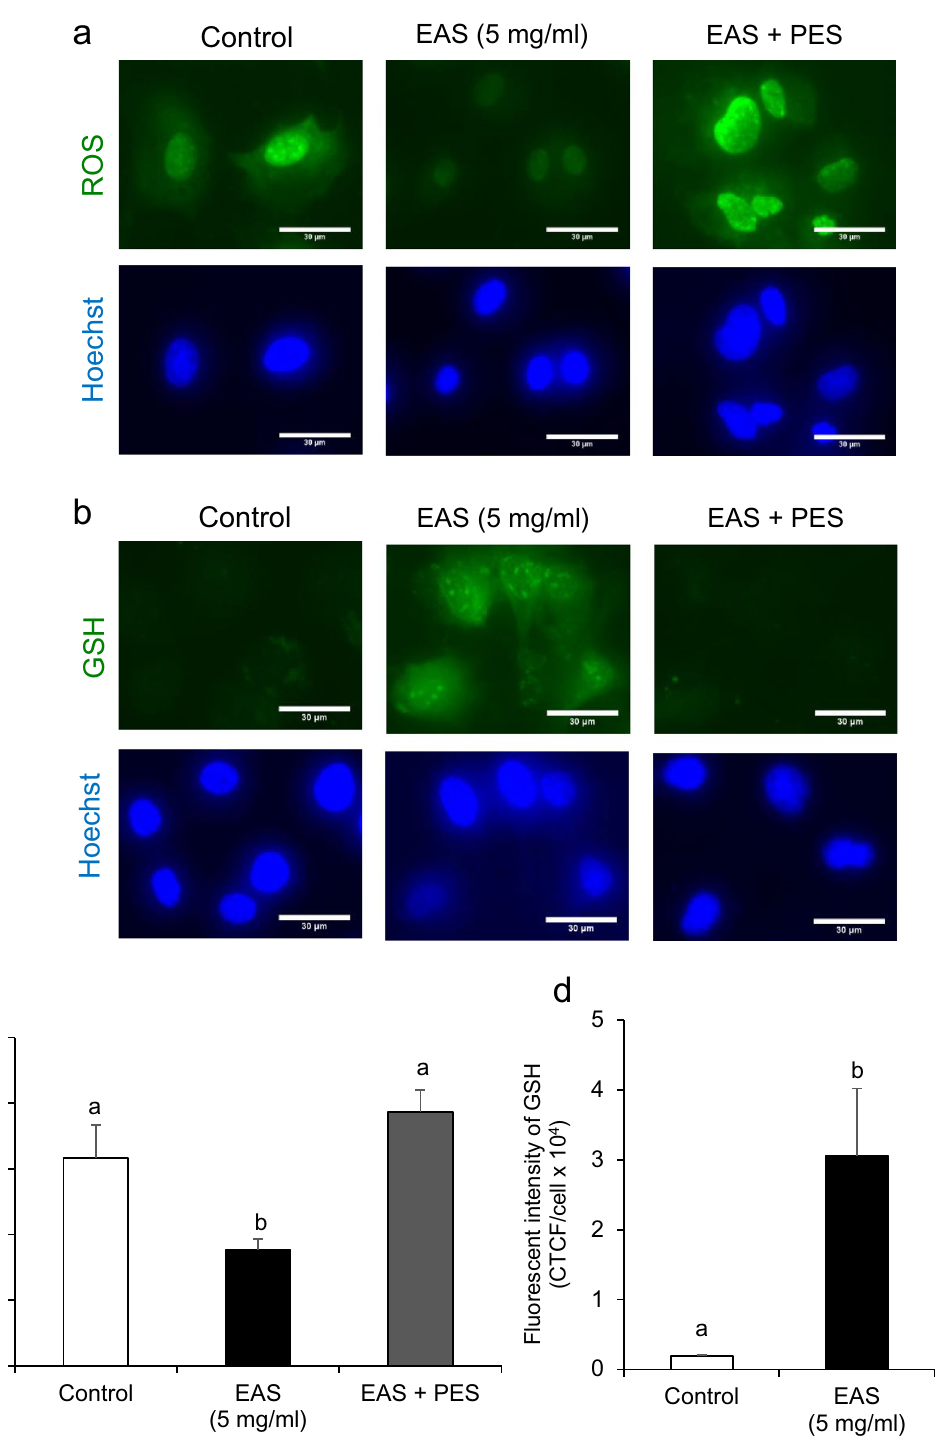
Figure 8. Effect of EAS-induced HSP70 inhibition on GSH synthesis and ROS generation in bovine CG cells. Cells were treated for 6 h with or without EAS (5 mg/ml) under normal conditions at 38.5 °C (control, EAS group) and 10 µM PES together with 5 mg/ml EAS (EAS + PES). ( a ) Fluorescence of ROS (upper) and nuclei stained with Hoechst (lower). ( b ) Fluorescence of GSH (upper panel) and nuclei stained with Hoechst (lower panel). Scale bar shows 30 μm. ( c ) Fluorescence intensity of ROS (CTCF). Bar shows 30 μm. ( d ) Fluorescence intensity of GSH (CTCF). ( c ) Data are shown as mean ± SEM, n = 5, a vs. b ( P < 0.05). ( d ) Data are shown as the means ± SEM, n = 5, a vs b ( P <